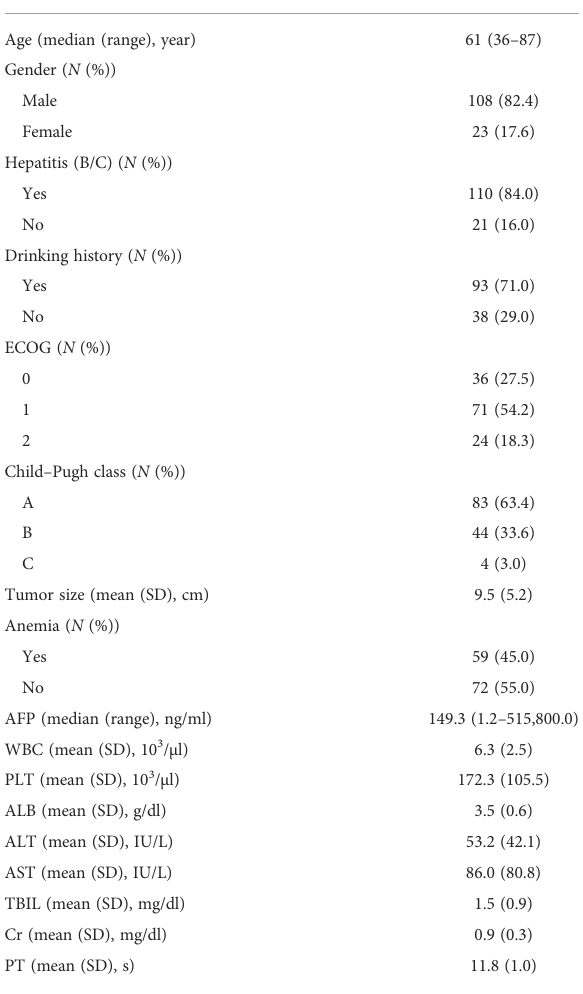
TABLE 1 Baseline characteristics of all